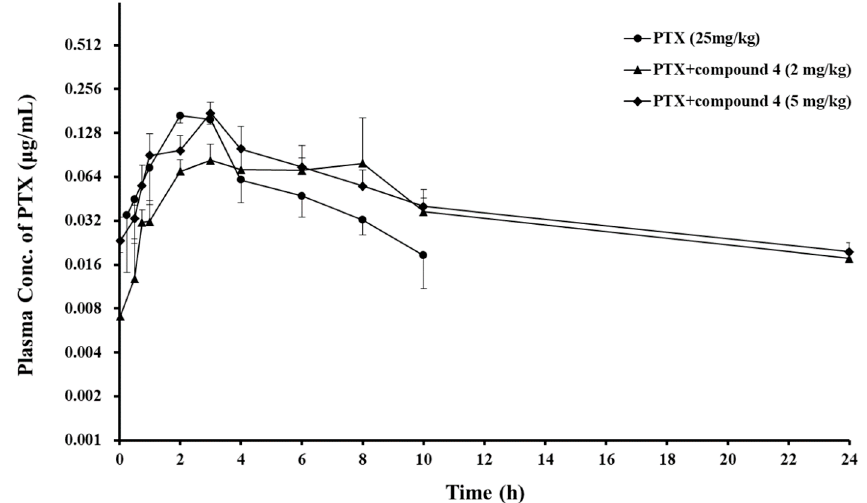
Figure 3. Mean plasma concentration–time profiles of the oral co-administration of PTX with piperazine derivative, compound 4 to rats. Bars represent S.D. ( n = 3–4). ( ● ) PTX (25 mg/kg, PO) alone, PTX (25 mg/kg) co-administrated with compound 4 ( ▲ ) 2, or ( ◆ ) 5 mg/kg. Table 3. PK parameters of PTX orally co-administrated with compound 4 (2 and 5 mg/kg, PO) in rats. PK Parameters